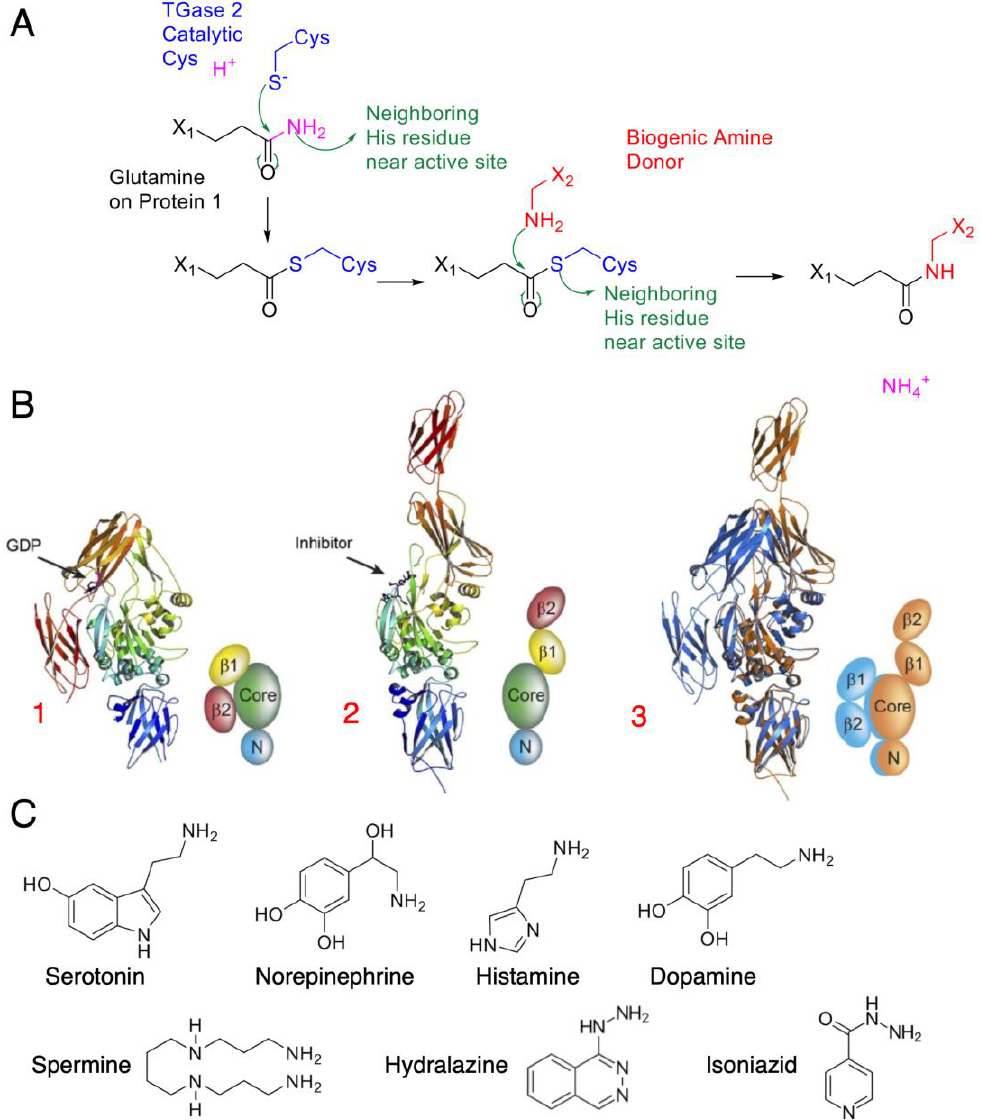
Figure 1. TGM2 mode of action and amine donor substrates: ( A ) Catalytic mechanism of TGM2, with green arrows indicating electron movement. TGM2 catalyzes transamidation reactions between a protein at its glutamine residue and various amine donors. The reaction is first initiated by a nucleophilic attack by the activated cysteine on the glutamine amide, forming the thioester interme- diate. A biogenic amine donor leads to another nucleophilic attack and completes the transamidation reaction. ( B ) Crystal structure of tissue transglutaminase. TGM2 undergoes a large conformational change upon activation. In this figure, the crystal structures are shown as ribbons; simplified car- toons are included for clarity [16] (© 2007 Pinkas et al., distributed under the terms of the Creative Commons Attribution License, which permits unrestricted use, distribution, and reproduction in any medium, provided the original author and source are credited). The N -terminal β -sandwich is shown in blue (N), the catalytic domain (Core) in green, and the C-terminal β -barrels ( β 1 and β 2) in yellow and red, respectively: (1) GDP-bound TGM2; (2) TGM2 inhibited with the active-site inhibitor Ac-P(DON)LPF-NH 2 ; (3) the N-terminal β -sandwich and catalytic domains of the two structures are superimposed, highlighting the conformational change. The GDP-bound structure is shown in blue, and the inhibitor-bound structure is shown in gold. ( C ) Common amine substrates for TGM2, with each serving a different purpose as neurotransmitters and transduction